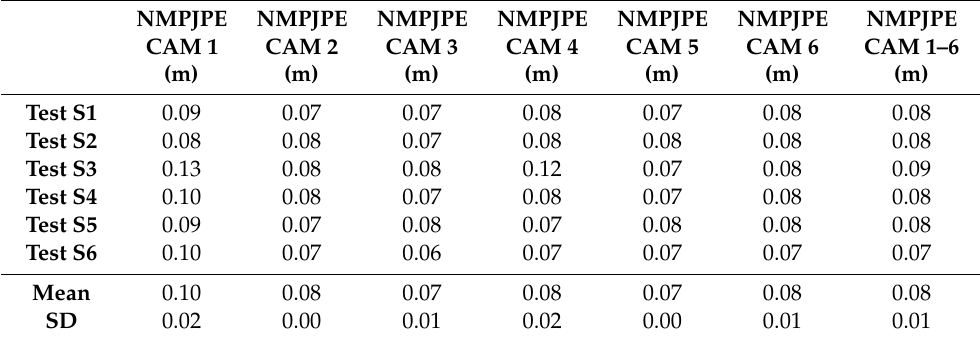
Table 2. Normalized mean per joint position error (NMPJPE) for a monocular computer vision-based 3D reconstruction using di ff erent camera